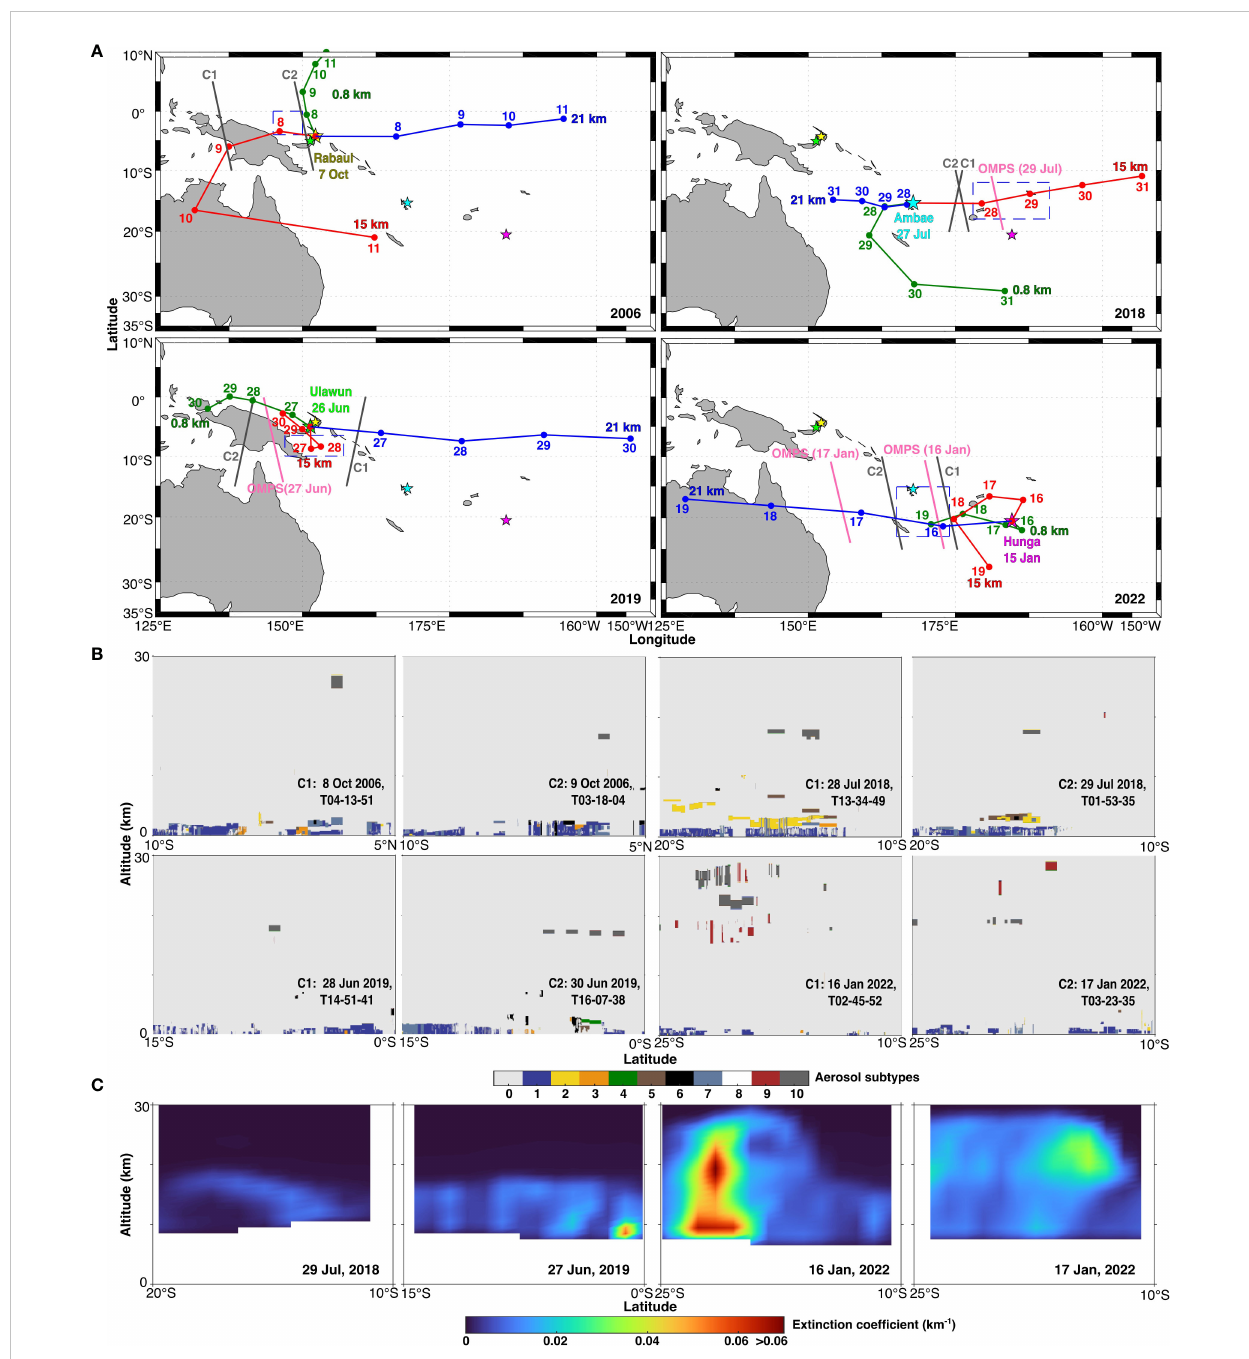
FIGURE 3 (A) The HYSPLIT forward trajectories (96-hrs) at altitudes of 0.8 km (green), 15 km (red), 21 km (blue) from Rabaul (7 October, 2018), Ambae (27 July, 2018), Ulawun (26 June, 2019), and Hunga (15 January, 2022). Grey lines indicate CALIPSO orbits. Pink lines indicate OMPS orbits. (B) The vertical distribution of CALIPSO-derived aerosol subtypes in 2006, 2018, 2019 and 2022 along the orbits shown in (A) . Colorbar indicates stratospheric aerosol subtypes (0: not determined, 1: clean marine, 2: dust, 3: polluted continental/smoke, 4: clean continental, 5: polluted dust, 6: elevated smoke, 7: dusty marine, 8: polar stratospheric clouds aerosol, 9: volcanic ash, 10: sulphate/other). (C) The vertical distribution of OMPS-derived aerosol extinction coef fi cient on 29 July, 2018, 27 June, 2019, 16 and 17 January, 2022 along the orbits shown in Figure